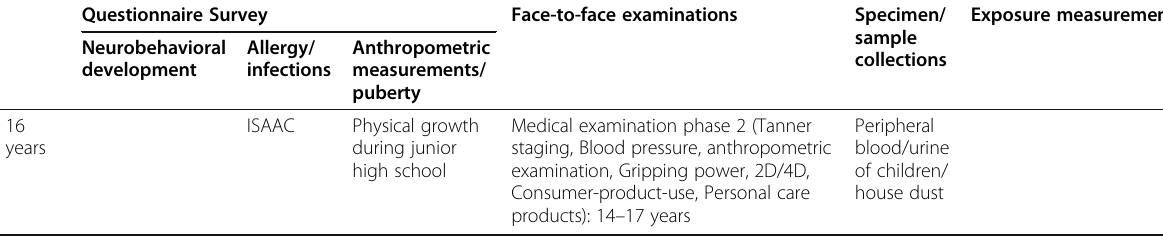
Table 2 Follow-up studies (Sapporo and Hokkaido cohorts)